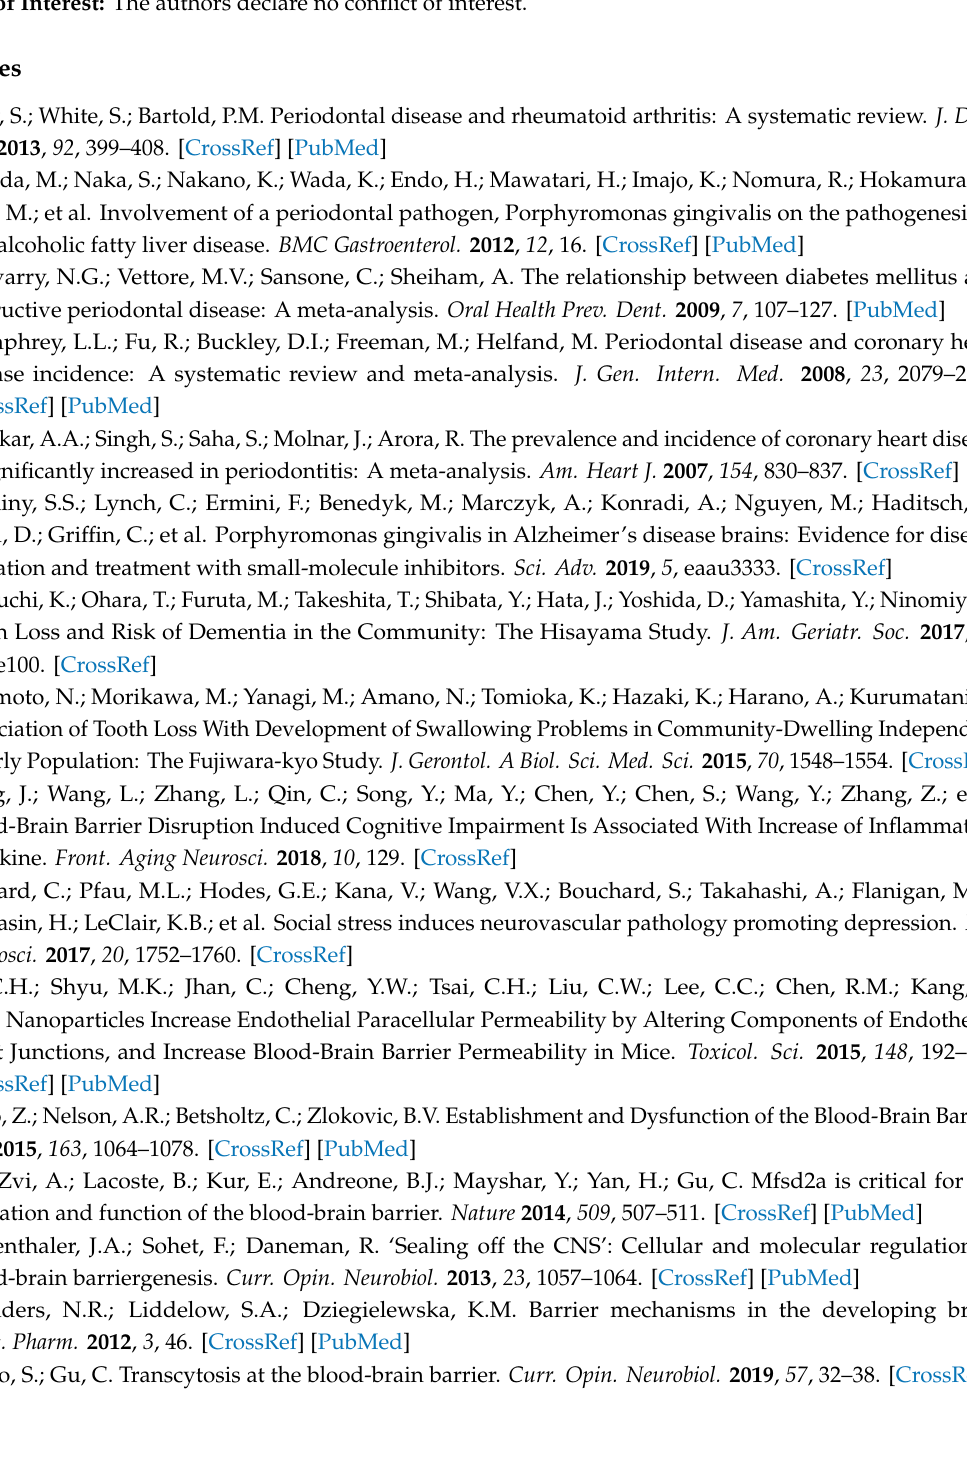
Figure S2: The e ff ect of ligature-induced PD on the levels of ZO1 in blood vessels in the hippocampus. Figure S3: The e ff ect of ligature-induced PD on the levels of Occludin in blood vessels in the